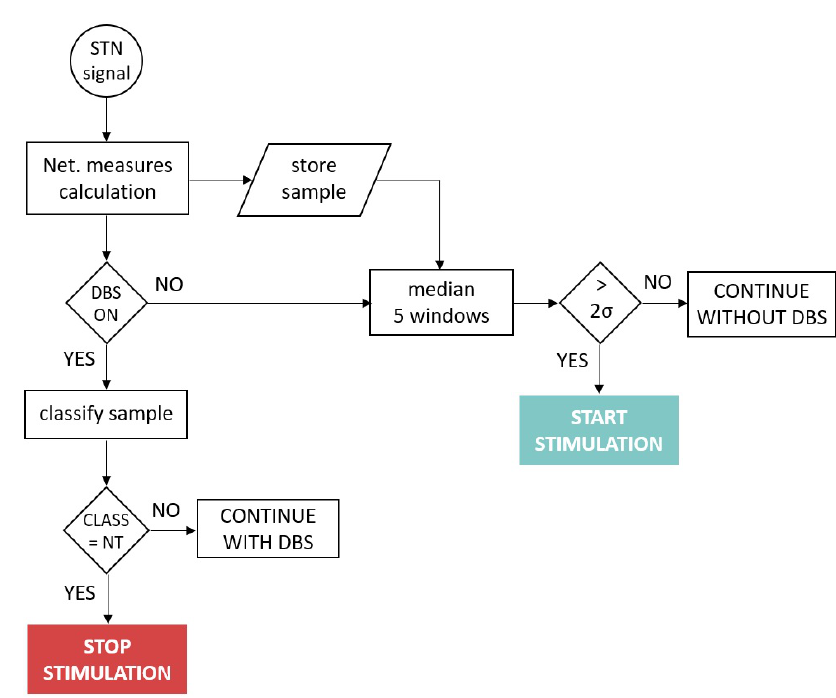
Figure 4. Flow diagram of the system operating